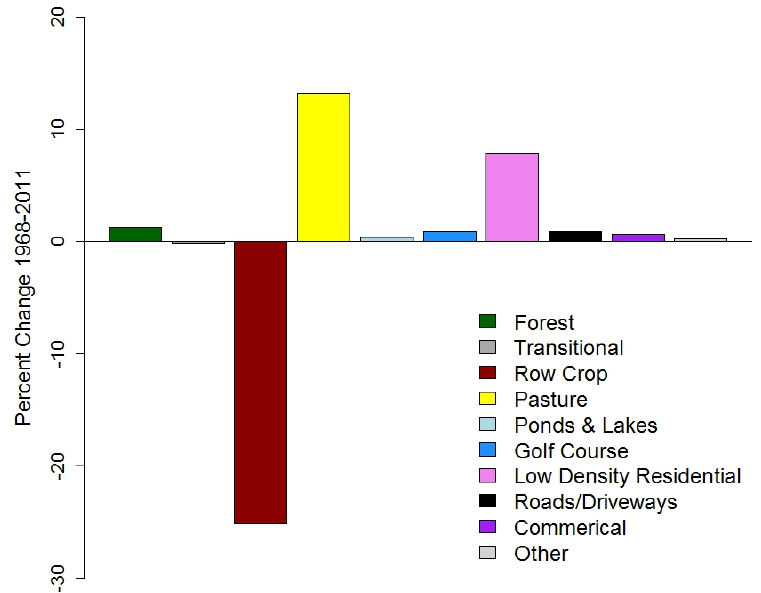
Figure 5. Change in percent of total area for different land covers for the Doddies Creek watershed between 1968 and